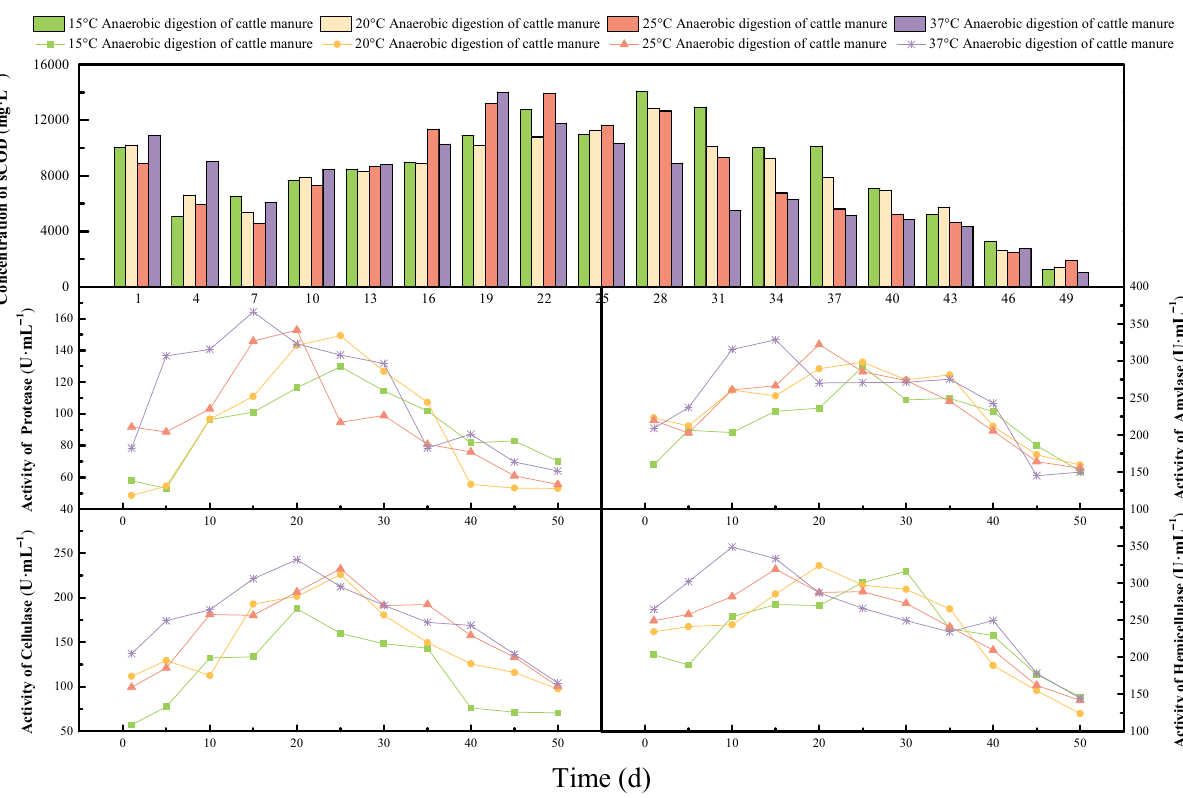
Figure 3: Relationship between the sCOD concentration and di ff erent enzyme activities in the anaerobic digestion of cattle manure at sub - mesophilic